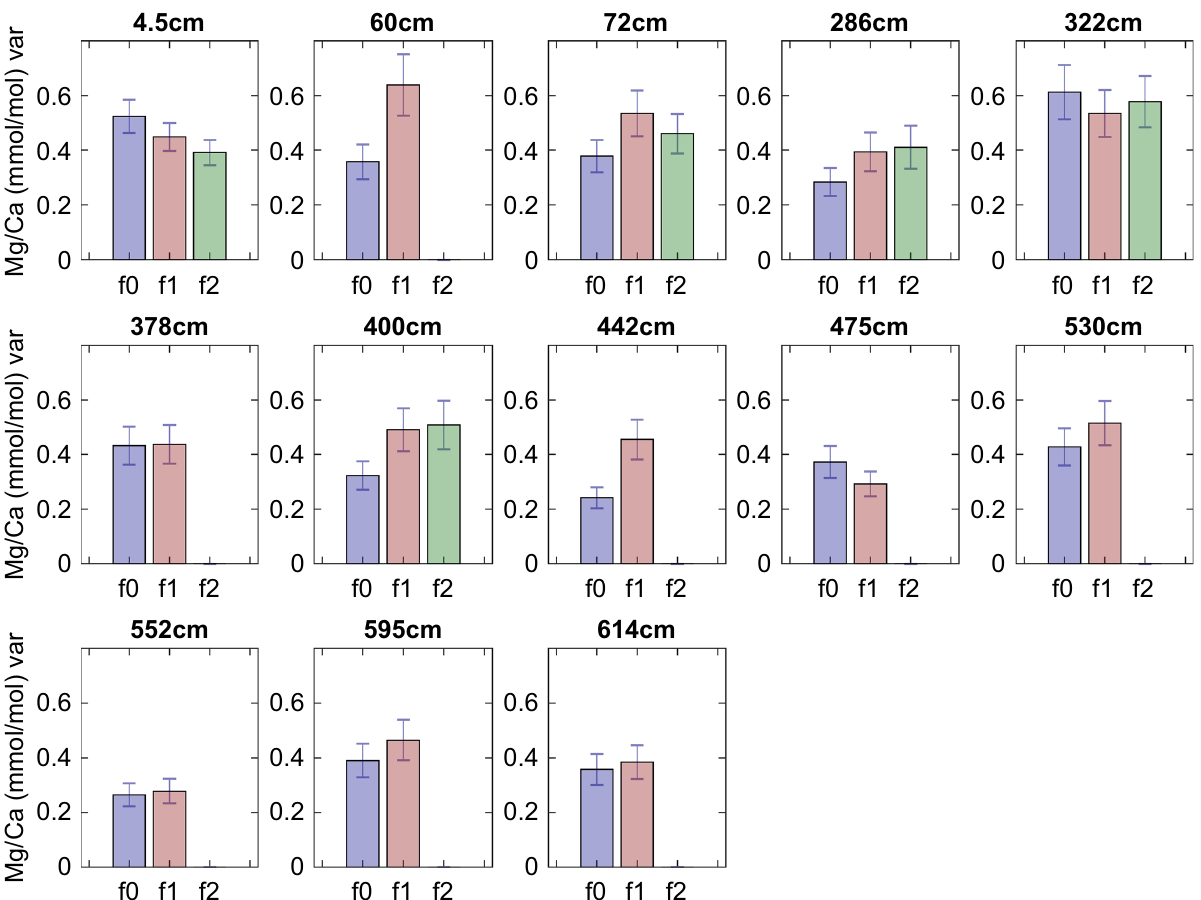
Figure 3. Variance of Mg/Ca values from each chamber at various sample depths. The error bars show the standard error of the variance. Significant differences in variability (one-sided f-test, p < 0.05) between f0 and f1 chambers are found at 60 cm, 400 cm and 442 cm, and between f0 and f2 at 400 cm. No intervals show significant differences between f1 and f2 chamber